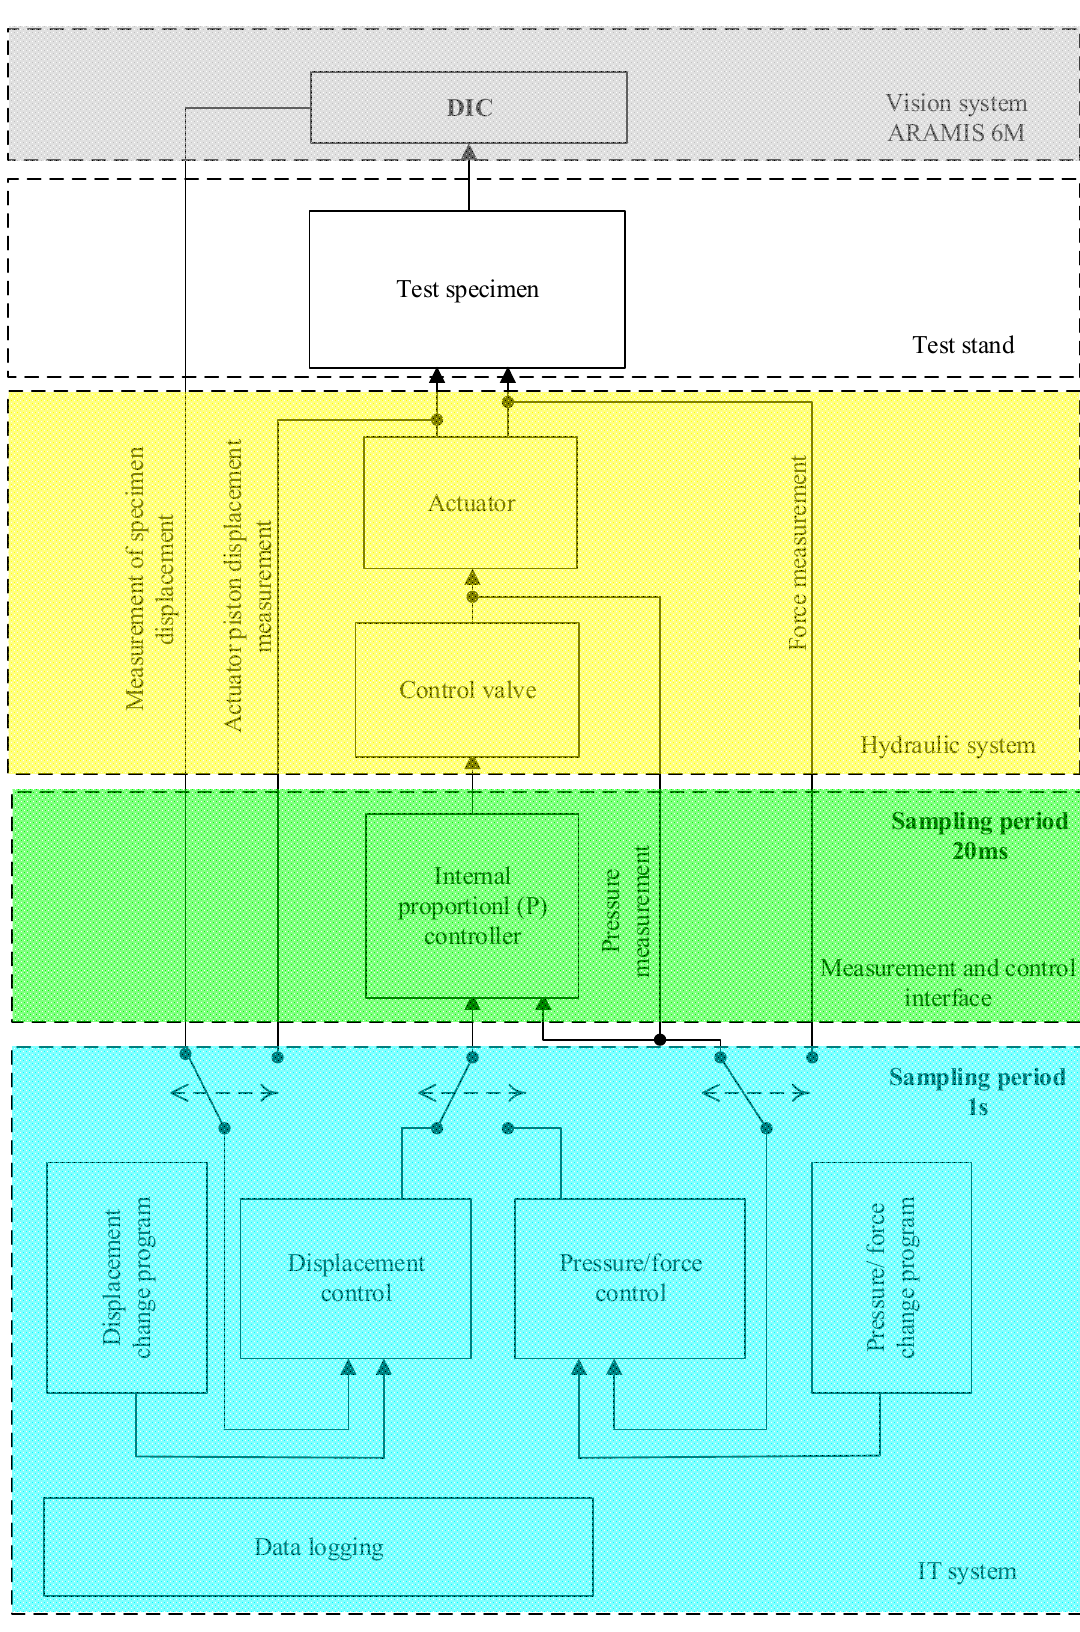
Figure 6. Schematic diagram of displacement or load control system.